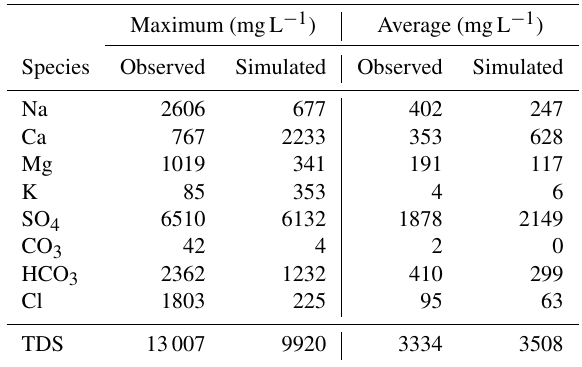
Figure 10. Simulated daily mass loading of TDS (kg) to the Arkansas River via groundwater discharge for the SWAT model with uniform initial salt concentrations. Results from a salt mass balance calculation on the Arkansas River are also plotted, show- ing the unaccounted-for TDS loadings (groundwater, surface runoff, small inflows) in the Arkansas River. Table 2. Summary statistics for observed (monitoring well) and simulated (SWAT) salinity concentrations in